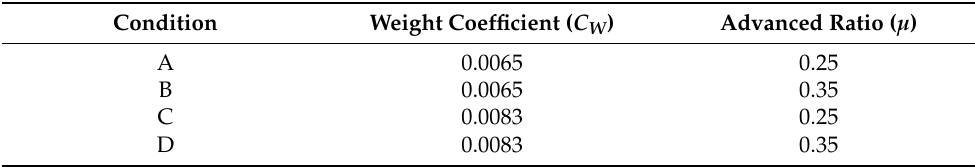
Table 2. Summary of flight conditions.